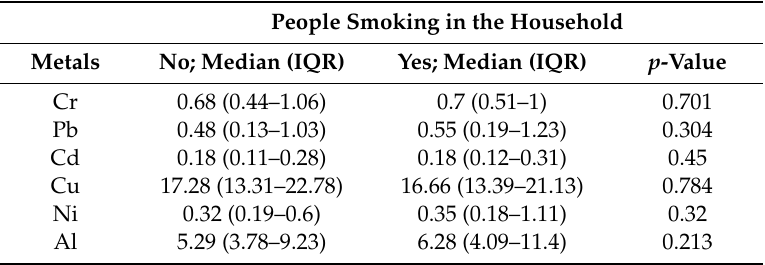
Table 2. Median with interquartile range (IQR) of toenail heavy metals ( µ g / g) by smoking